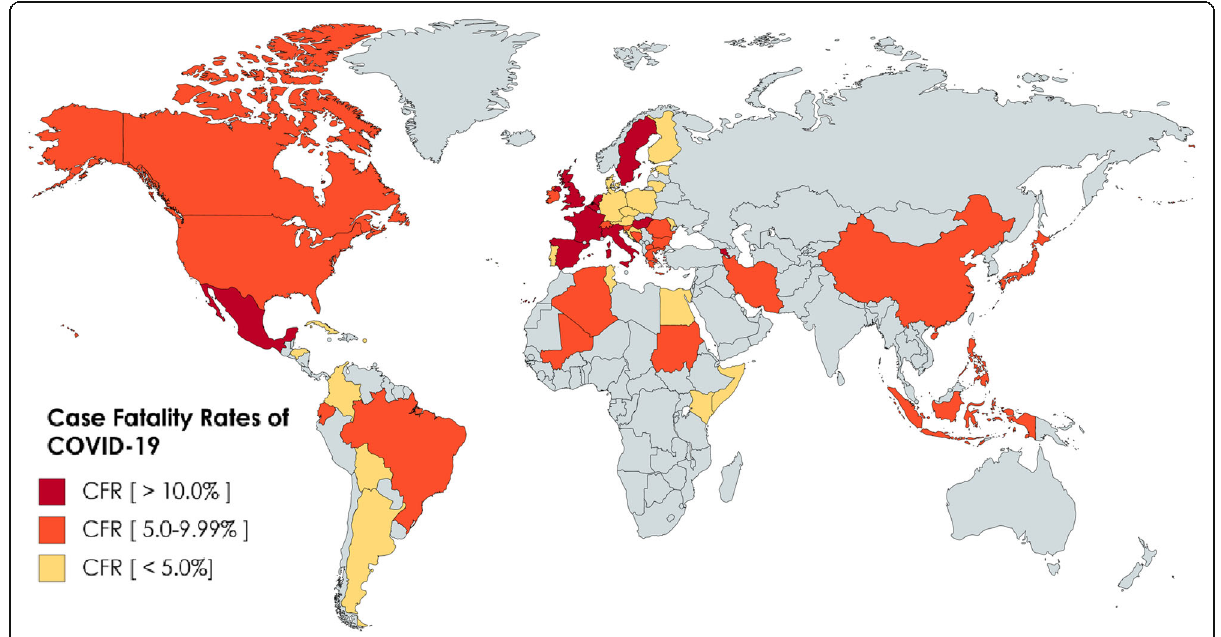
Fig. 2 Case Fatality Rate world map, based on data accessed on June 3, 2020. CFR is defined as the number of deaths divided by the number of incident patients within a specified time. CFR is least affected by reporting bias but maybe underestimated by time lag bias due to diagnosing and reporting cases, and the assumption that all cases have been reported, while it may be overestimated by the definition of a case, either confirmed or closed. This map depicts the CFR so far. The highest CFR (> 10%) is reported in Belgium (16.21%), France (15.47%), Italy (14.35%), Hungary (13.54%), the Netherlands, Sweden (11.64%), Spain (11.32%), and Mexico (10.58%). Comparing this map to the IDA prevalence Map in Fig. 1, a stark contrast is seen. Countries with high IDA prevalence have yet to report CFR > 3%. This includes the majority of SSA, excluding Kenya and Mali, as well the South East Asia. Meanwhile, countries with mild anemia prevalence appear to be reporting much higher CFR. There appears to be a connection between severe anemia and lesser CFR, bolstering the notion that the anemic defense is an evolutionary response to acute infection in the endemic setting, a chronic anemia “ herd immunity ” of sorts that may protect populations rather than a case by case